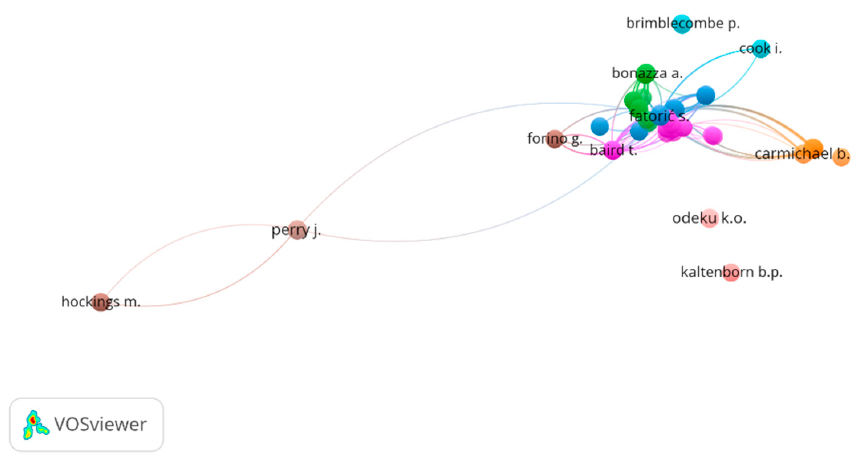
Figure 10. Author bibliographic coupling. Source: own elaboration.